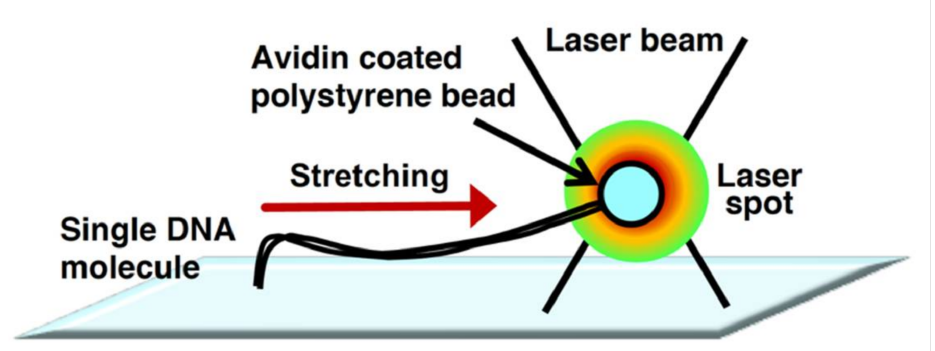
Figure 3. Physical manipulation of a single DNA molecule attached to microbeads using optical tweezers. Conceptual diagram of DNA manipulation by optical